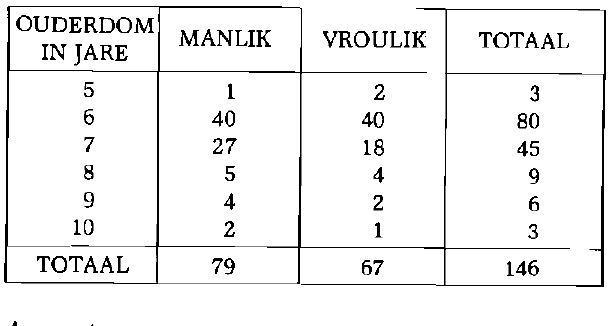
Tabel 2: Suiwertoon- en immittansiesiftingstoetsresul-